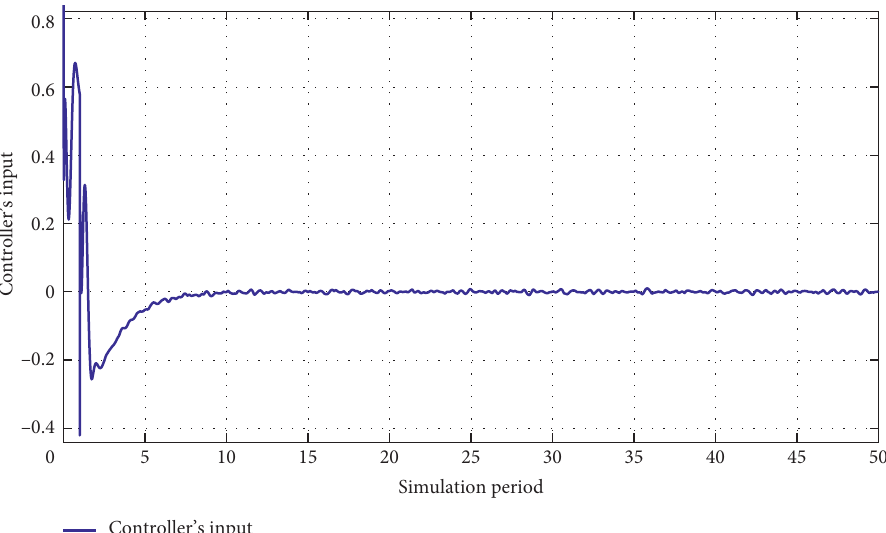
Figure 6: Reference Input data (PID controller) of the controller.